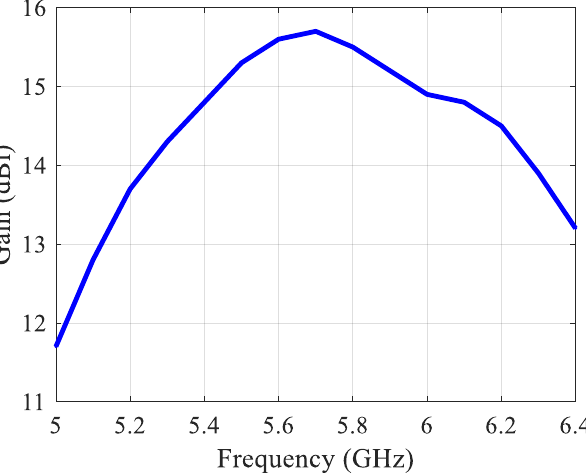
Figure 24. Simulated gain of the 2 × 6 array in the case of in-phase excitation of the three MIMO ports.